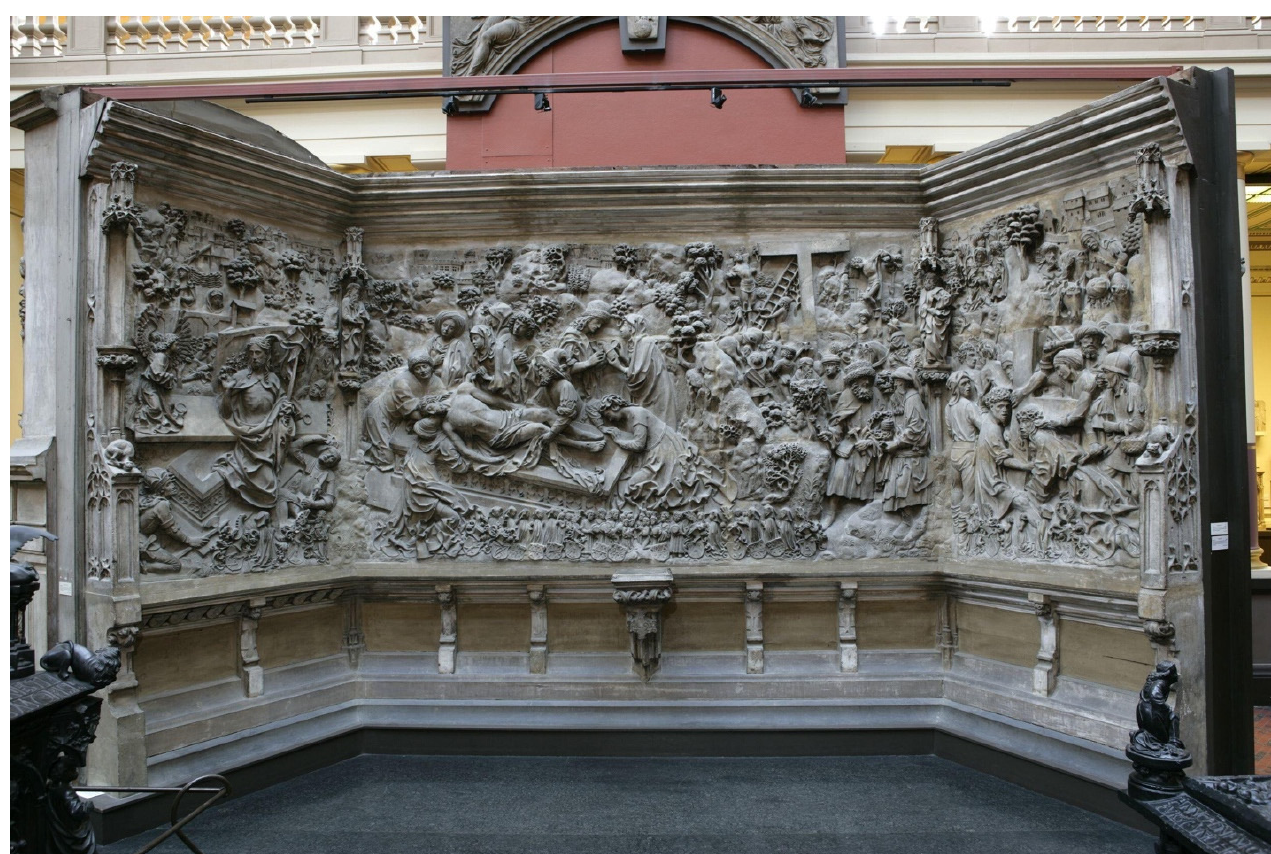
Figure 2. Kraft, Schreyer–Landau Epitaph, St. Sebald’s, Nuremberg, 1490–1492 (Cast; London, Victoria and Albert Museum).